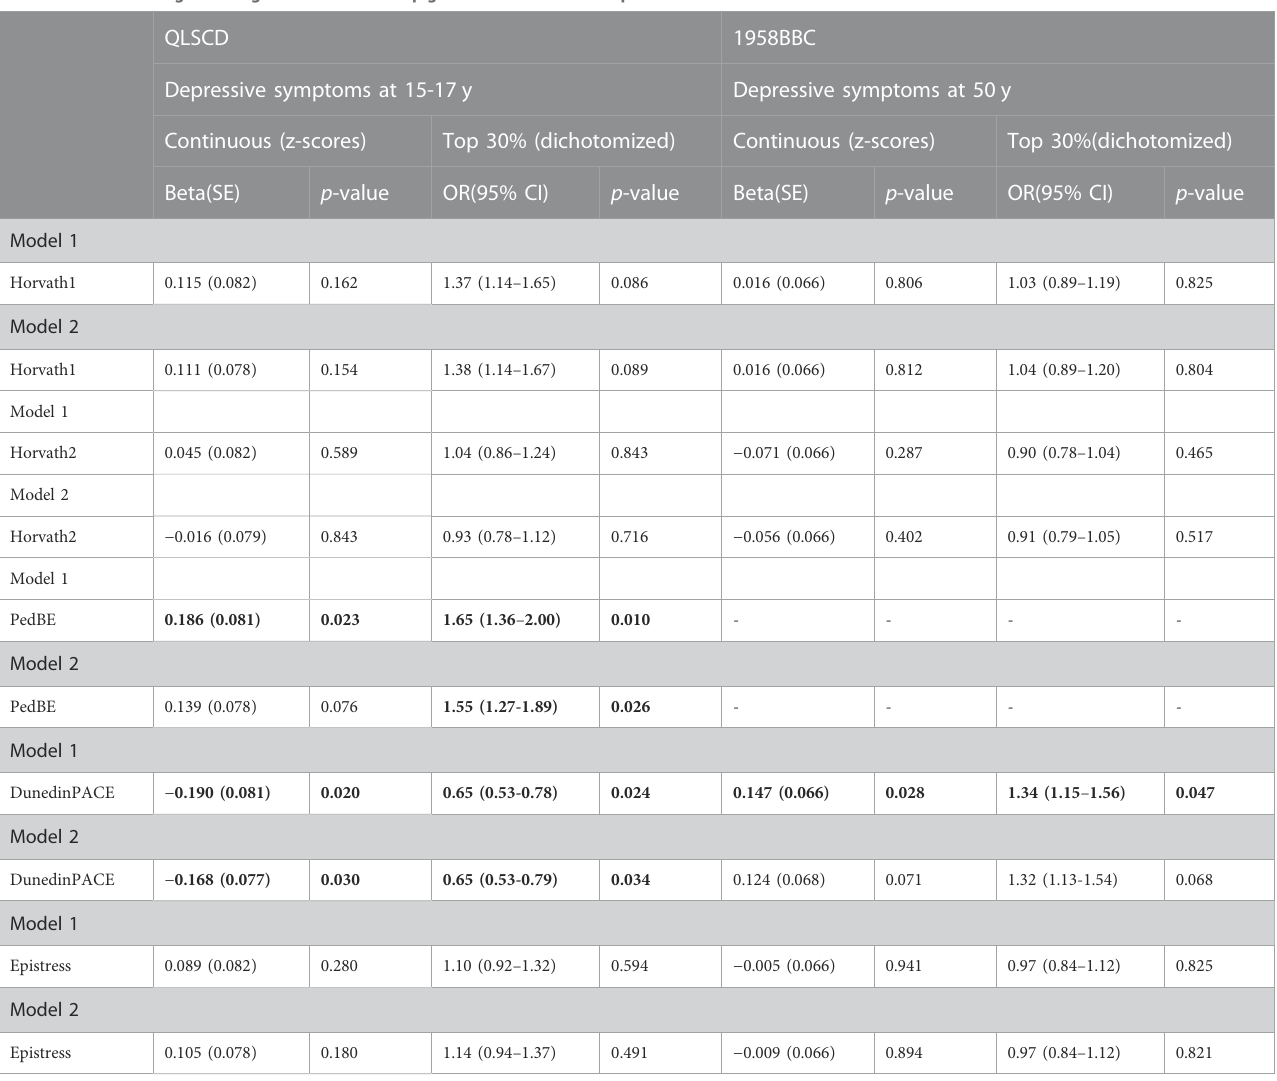
TABLE 4 Linear and logistical regressions between epigenetic residuals and